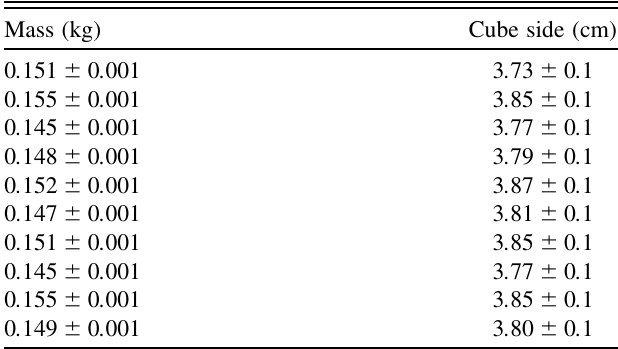
TABLE VII. Results of several measurements of cube’s mass and side.